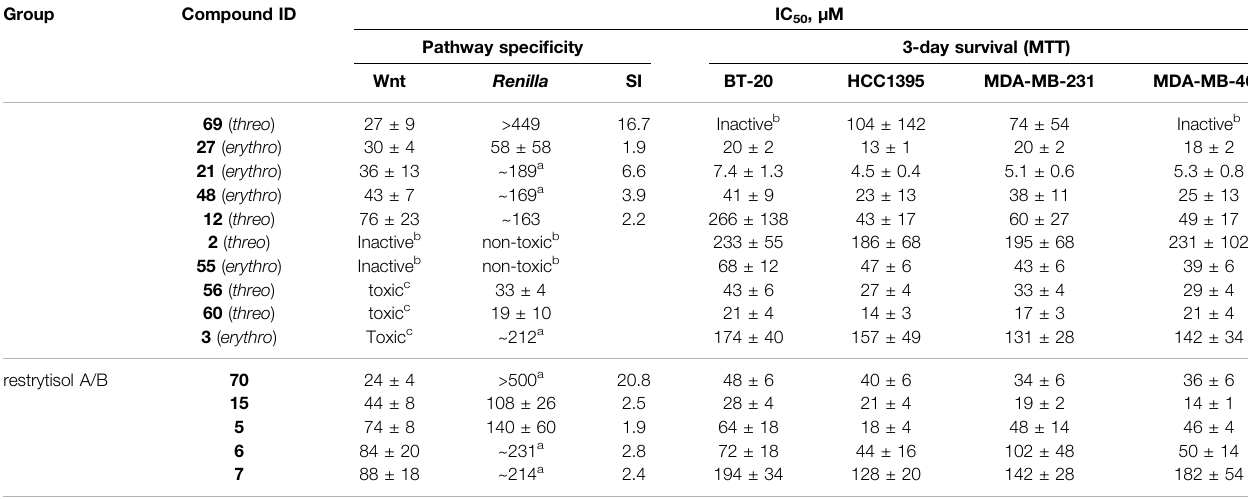
TABLE 1 | ( Continued ) IC 50 s of the investigated compounds against Wnt pathway and breast cancer cell survival.